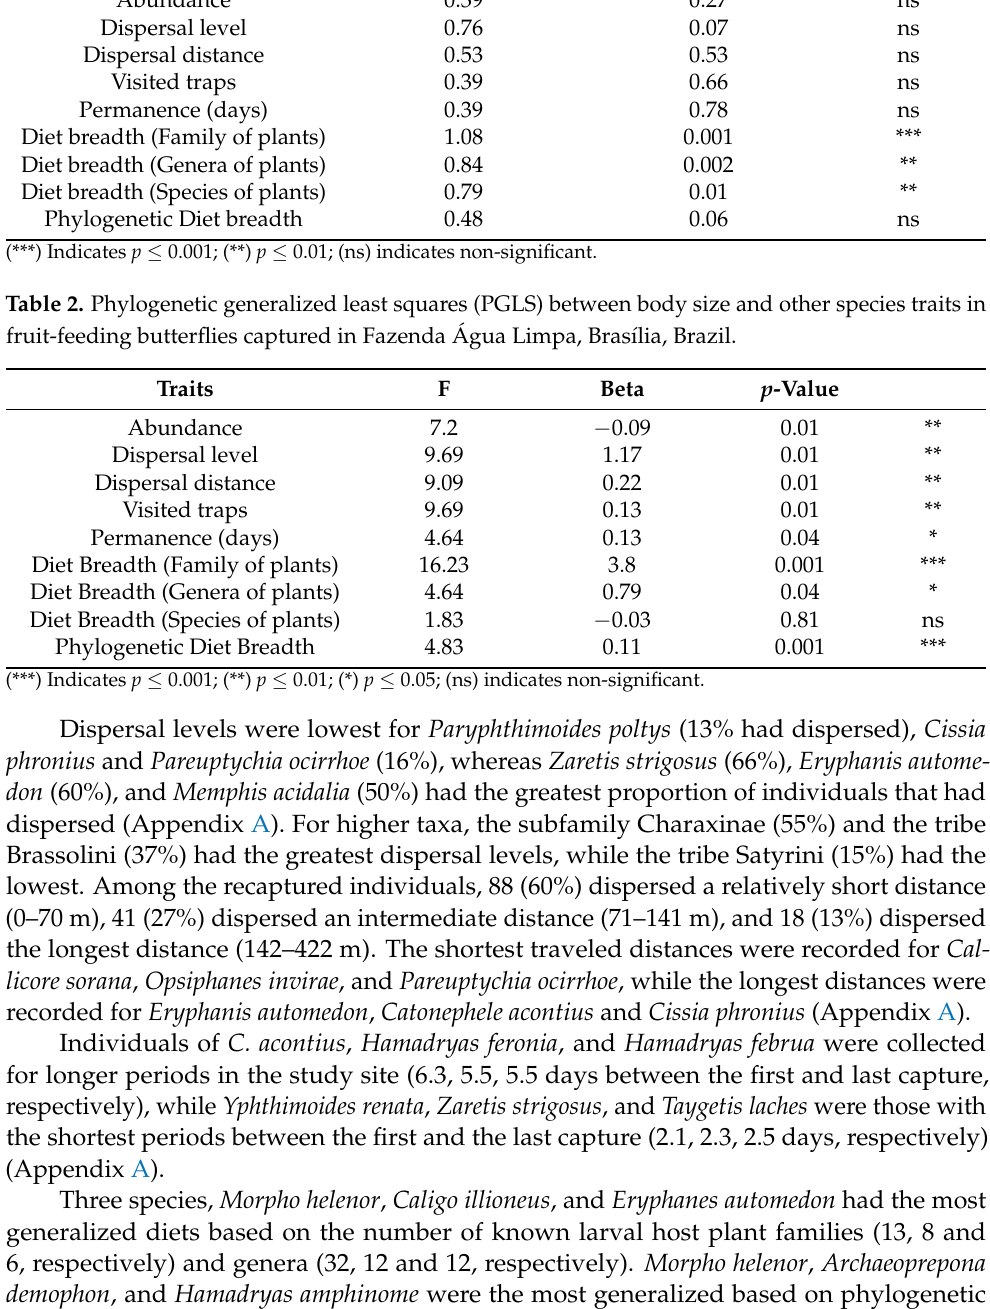
Table 1. Phylogenetic signal values (Blomberg’s K and p -value) of the species traits measured in fruit feeding butterflies captured in Fazenda Á gua Limpa, Bras í lia, Brazil. Traits Blomberg’s K p -Value Body size 1.1 0.001 Abundance 0.39 Dispersal level 0.76 Dispersal distance 0.53 Visited traps